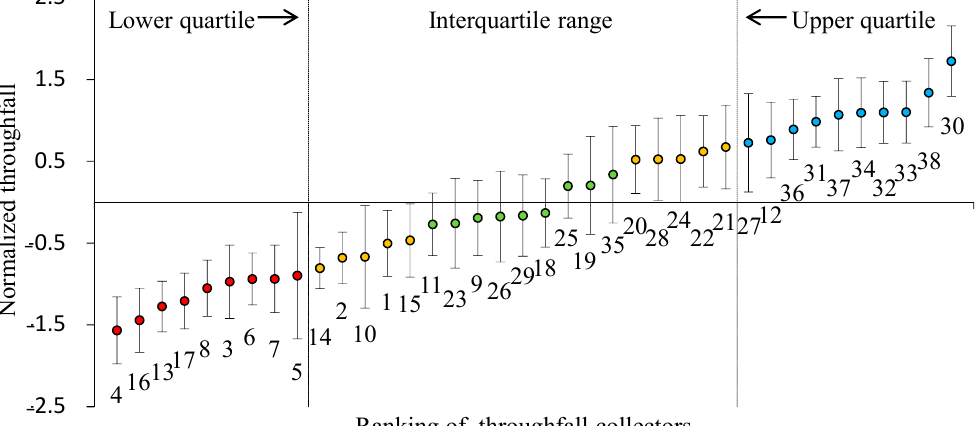
Figure 7. Temporal stability plot of normalized throughfall during the full leaf stage. The upper and lower error whiskers represent the 95% confidence interval. Red solid circles: extreme dry persistent collectors; blue solid circles: extreme wet persistent collectors; yellow solid circles: general persistent collectors; green solid circles: instability persistent collectors. The Arabic numerals represent the serial number of throughfall collectors.